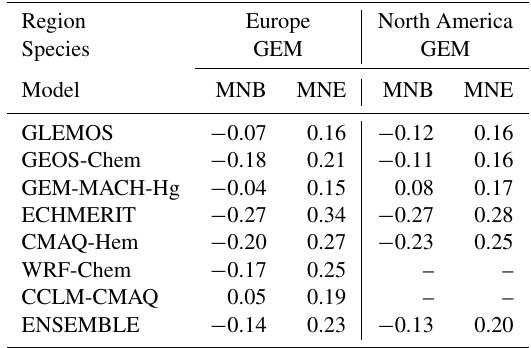
Table 3. Mean normalized bias (MNB) and mean normalized error (MNE) for each model as well as for the model ensemble for GEM in Europe and North America.